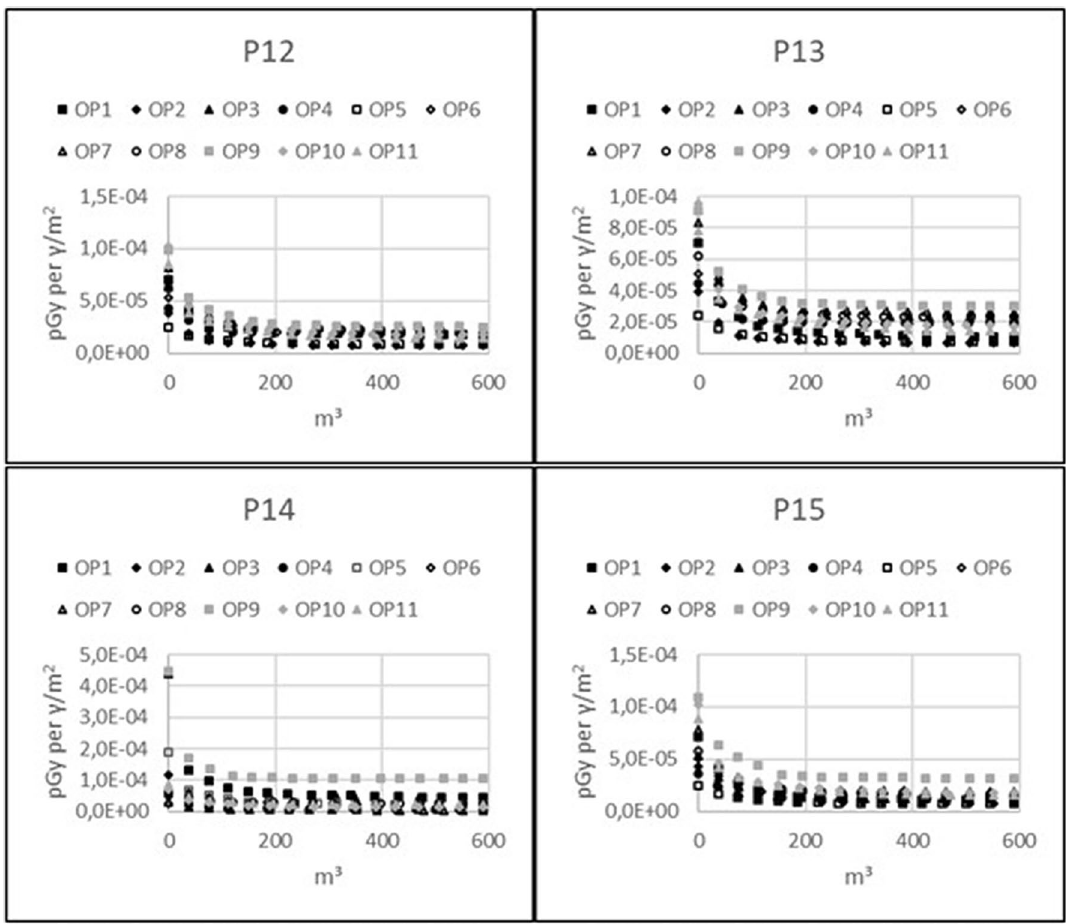
Figure 4. Reduction of absolute radiation exposure per volume of generated waste caused by topsoil removal for 11 observation points inside a brick house on properties